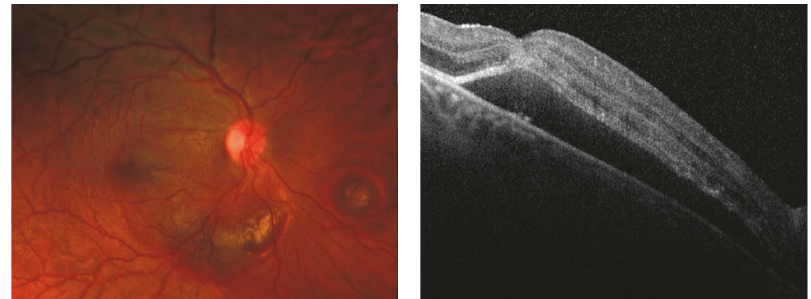
Figure 1: Fundus photograph and Spectral-Domain Optical Coherence Tomography (SD-OCT) of the right eye two days after presentation demonstrating submacular hemorrhage (SMH) involving the fovea.